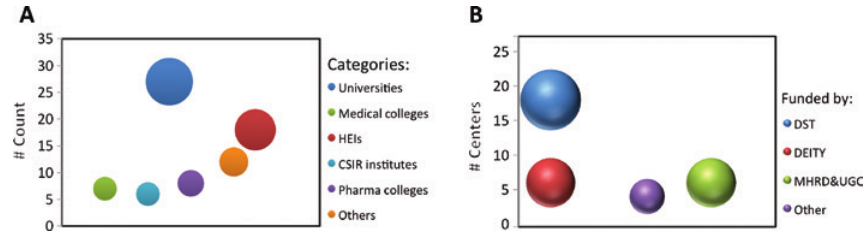
Figure 5: Sources of nanomedicine technology in India. (A) Categorization of academia involved in nanomedicine in India. (B) Number of specialized centers funded by different funding agencies (source: compiled by authors from websites of DST, DBT, ICMR, and institutes).